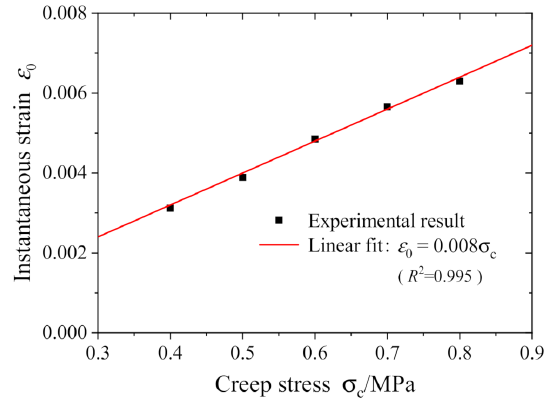
Figure 5. Initial instantaneous strain for various creep